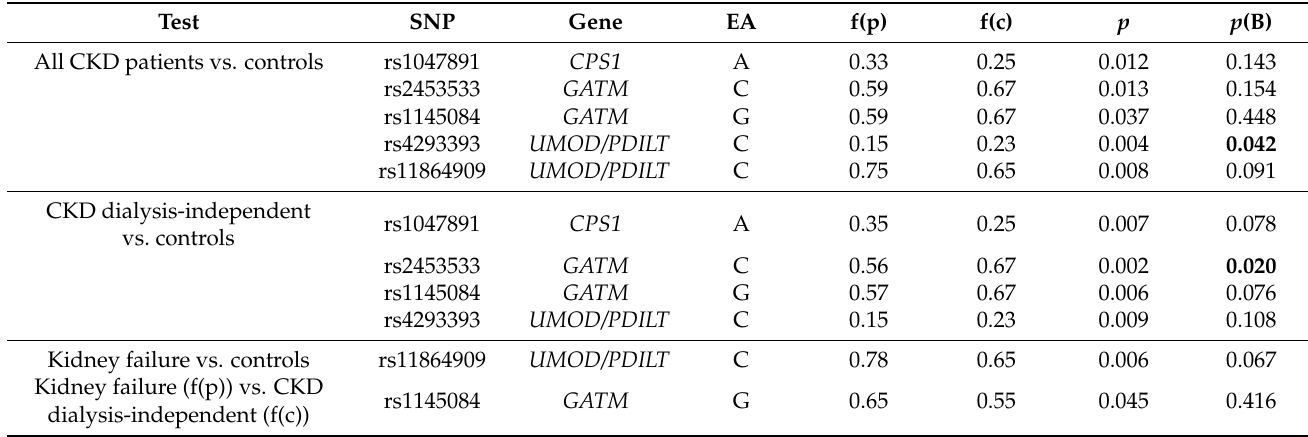
Table 2. Associations in Fisher’s exact case-control analysis between CKD patient groups and the healthy control group with unadjusted p values below 0.05.